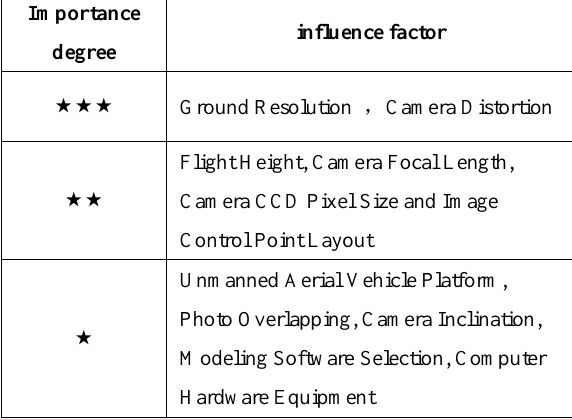
Table 2. Importance of Influencing